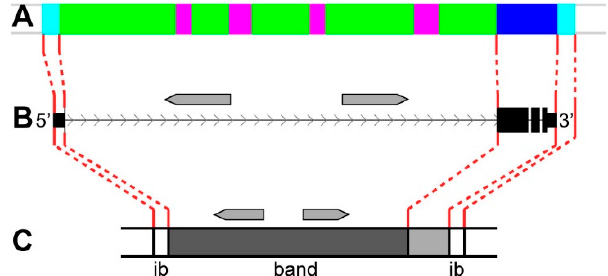
Figure 21. The scheme of the polytene chromosome band organization. The predominant long “main” gene contains exons and intron material; grey arrows represent shorter genes located within the introns of the “main” gene. ( A ) the four chromatin-state model [39]; ( B ) studied genes; and, ( C ) bands and interbands (ib) of polytene chromosome structure comprising the genes studied.